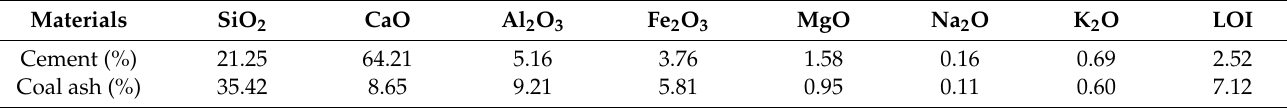
Table 4. Chemical properties of Jhelum aggregates. CaO